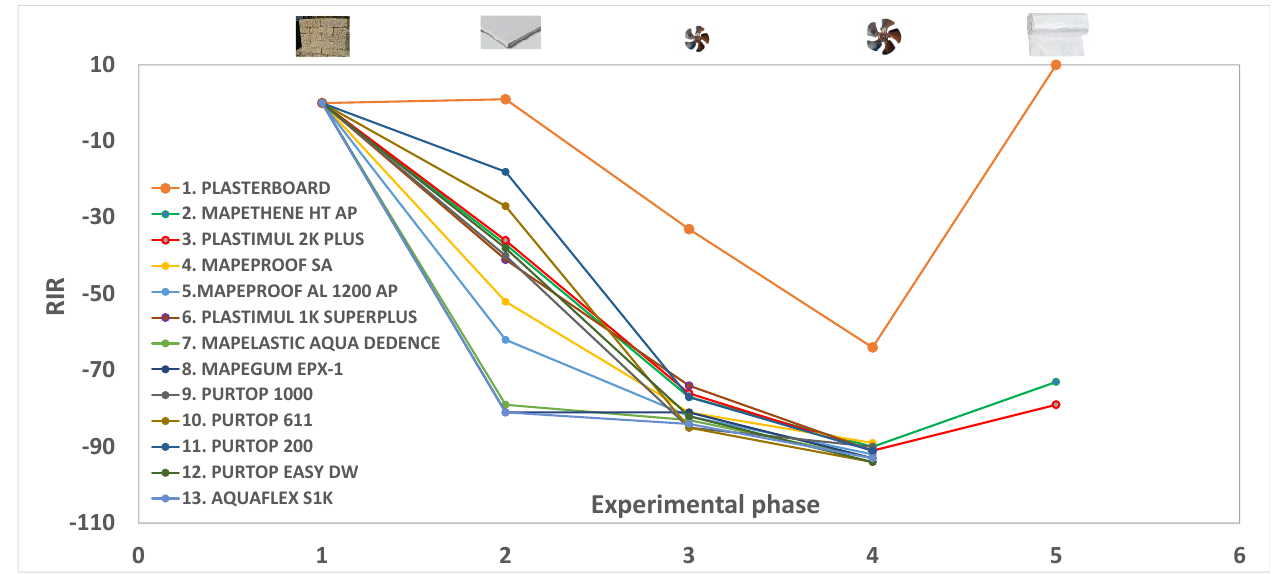
Figure 3. Relative change of Indoor Radon (RIR) during the five experimental parts of 13 experiments. See the text and Table 2 for an explanation.